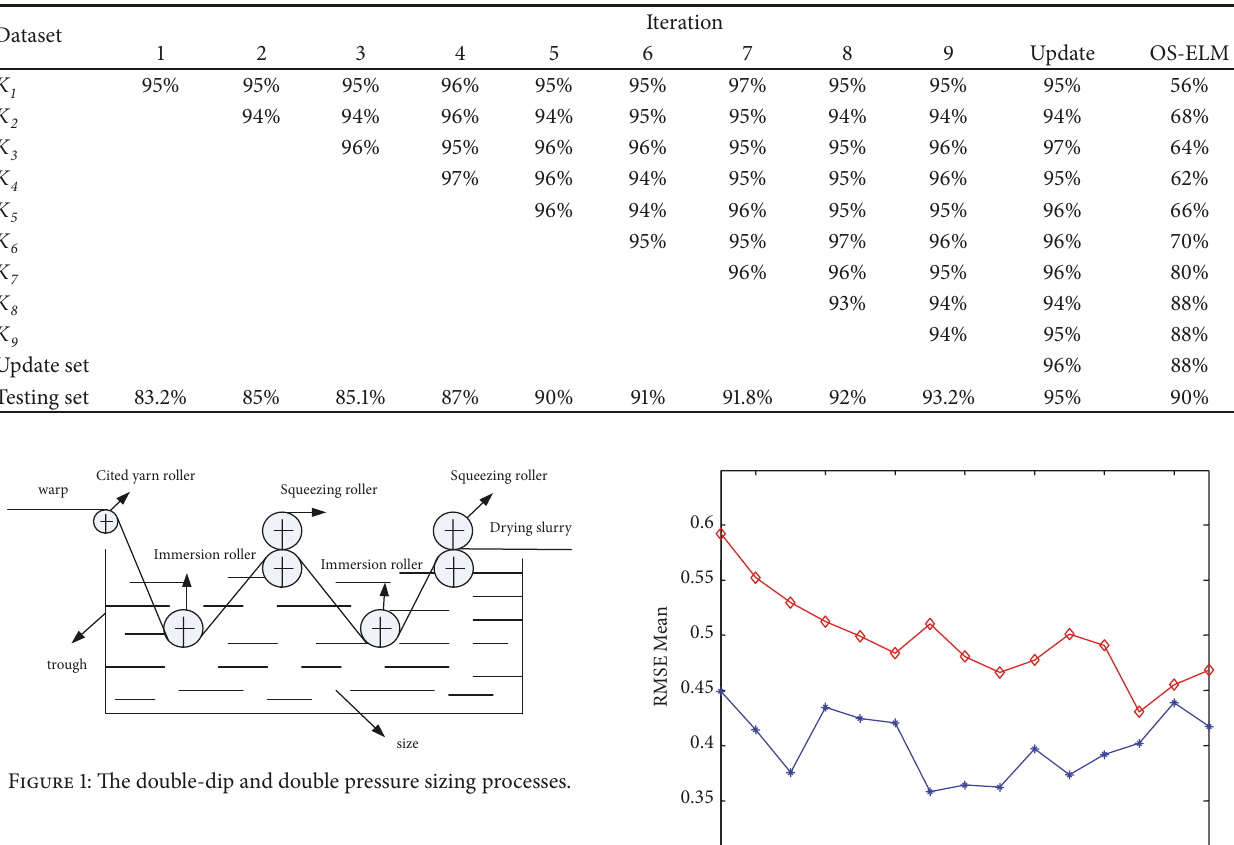
Table 2: The changes in the soft sensor accuracy during the learning process of the ILES.